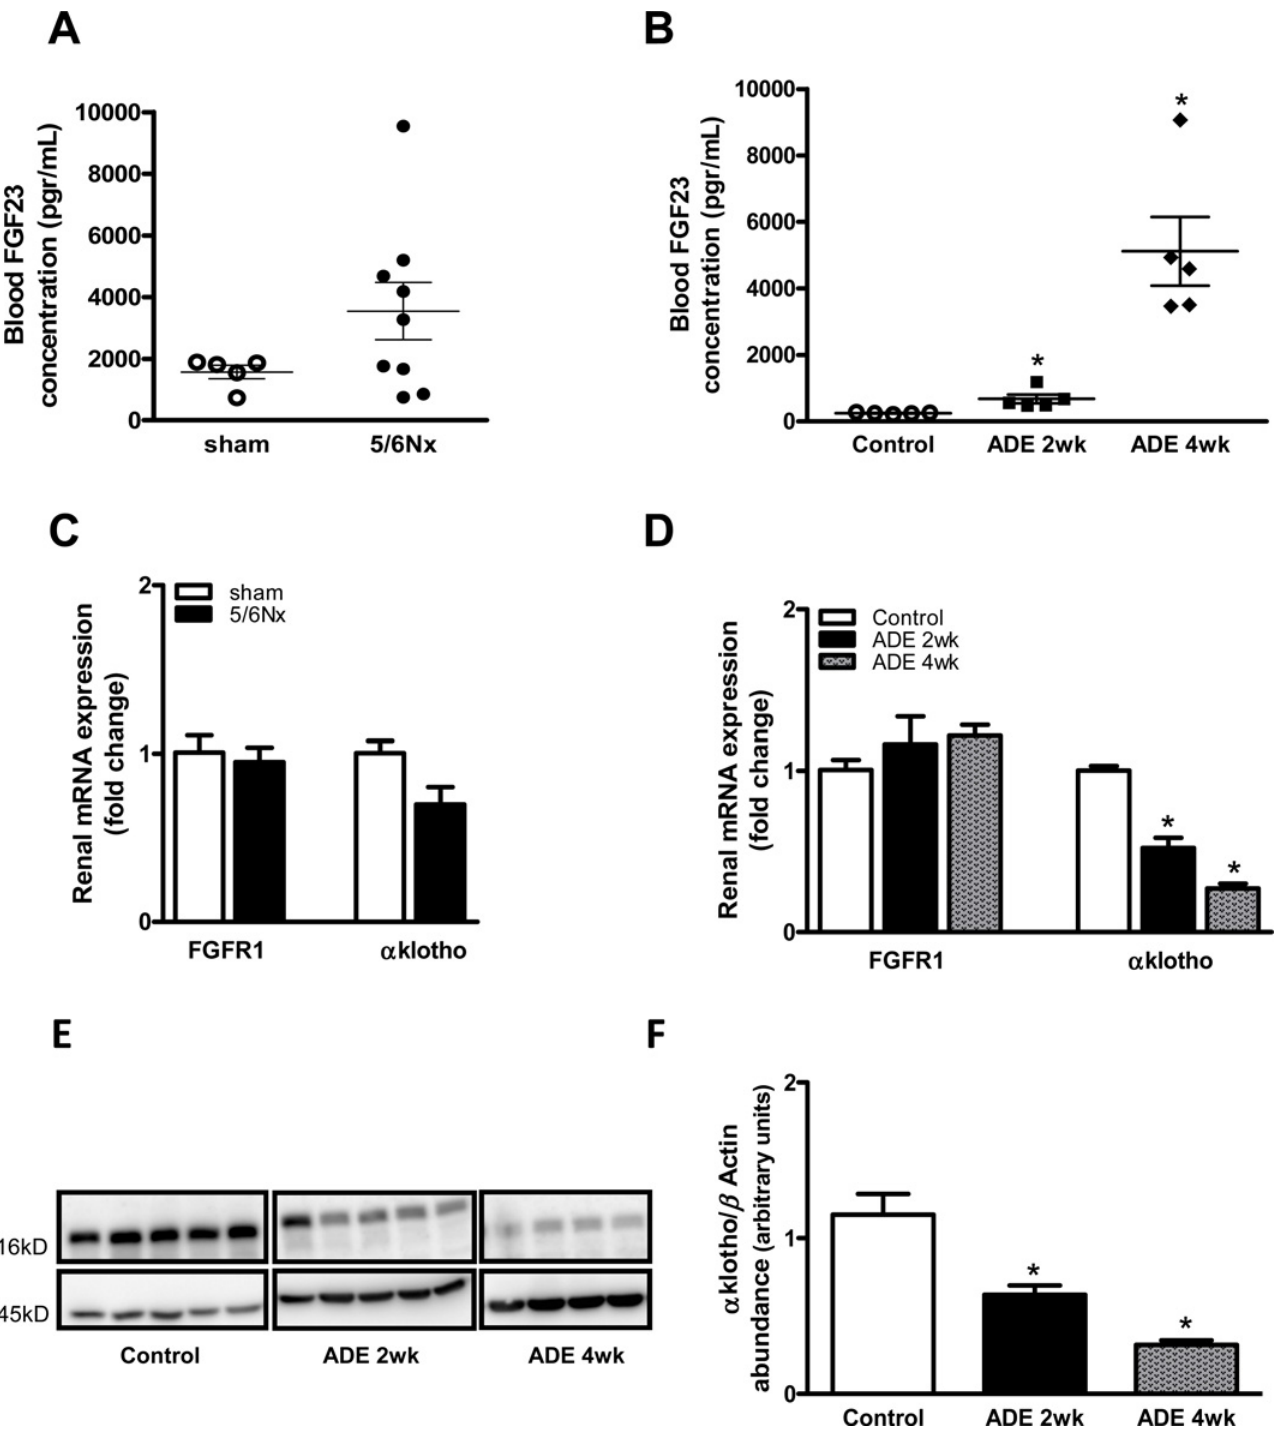
Fig 2. Progression of CKD altered FGF23- α klotho signalling. Experimental CKD deregulates FGF23- α klotho signalling as reflected by (A) a tendency towards elevated circulatory FGF23 levels in 5/6Nx mice and (B) progressively elevated FGF23 levels in ADE treated mice compared to control mice. Renal mRNA expression of FGFR1 and α Klotho in (C) CKD induced 5/6Nx mice (black bars) compared with sham-operated groups (white bars) and in (D) 2 weeks (black bars) and 4 weeks (gray bars) ADE treated mice compared with control groups (white bars). (E) Representative immunoblot (all 3 groups are done in one blot) and (F) semi-quantitative analysis for α Klotho (E ; upper panel) and β -actin (E ; lower panel) protein expression in renal lysates of control or ADE treated mice, which indicates reduced renal α Klotho protein expression upon CKD. Data are mean ± SEM. * : p < 0.05 compared to control mice.